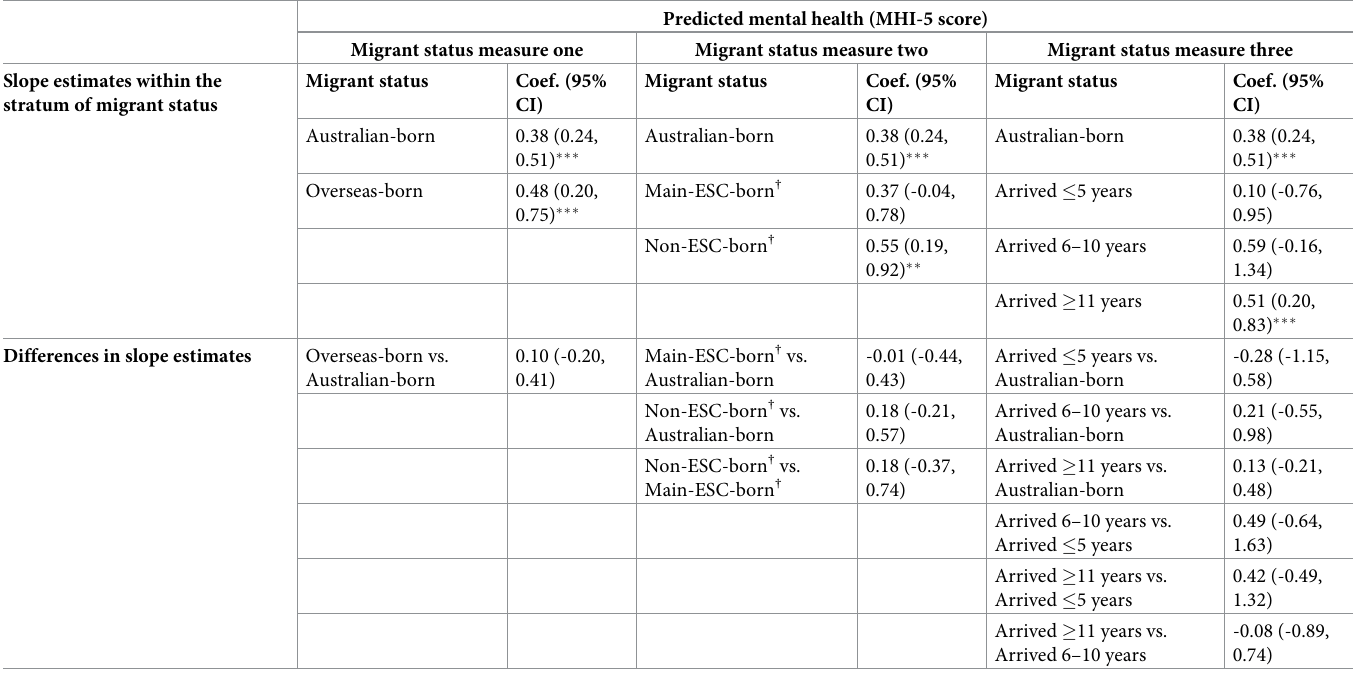
Table 3. Relationships between skill discretion and mental health stratified by three measures of migrant status: The slope estimate within each stratum of migrant status and the differences in the slope estimates between groups, controlled for gender, age and educational